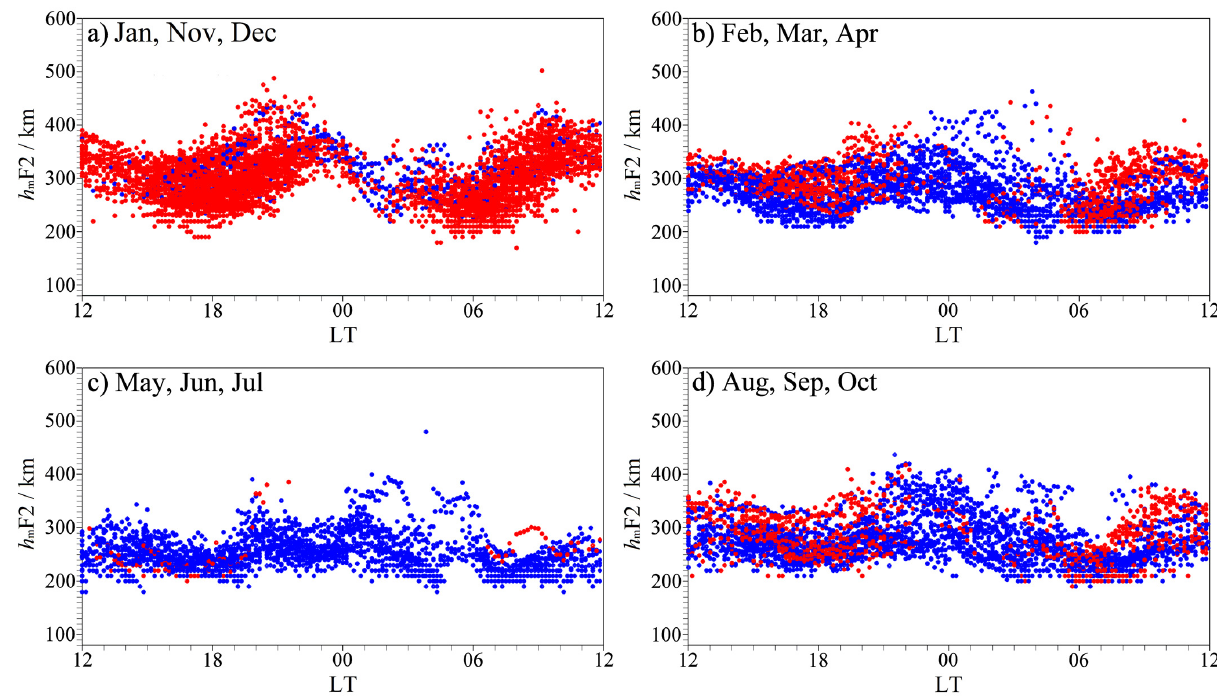
Figure 7. Overlapping h m F2 trends as a function of LT for the days in which spread F was not observed (blue dots), and days in which it was observed for more than 25% of the time (red dots) in ( a ) November, December, and January, ( b ) February,